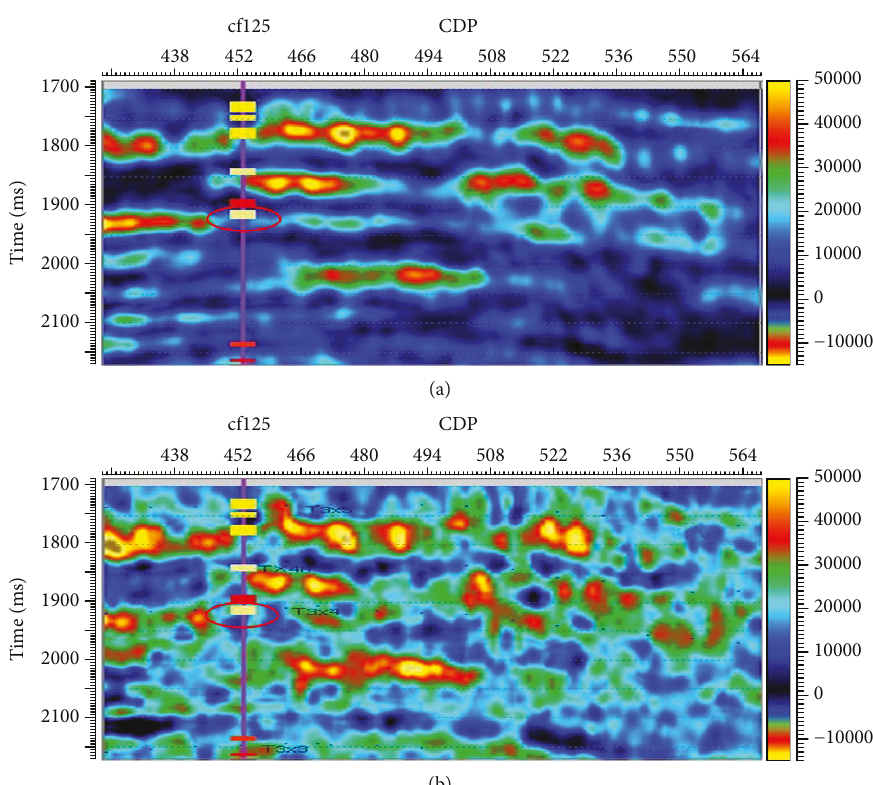
Figure 12: Inversion pro fi le through well cf125 by the new scheme (a) and Wilson ’ s (b). Two P – wave ’ s dispersion gradients at the location marked by red ellipse are low, and well test indicates the place is a poor gas reservoir (white block). Two inversion results match well test. But comparison shows that result by our scheme has better continuity and more contrast than that by Wilson ’